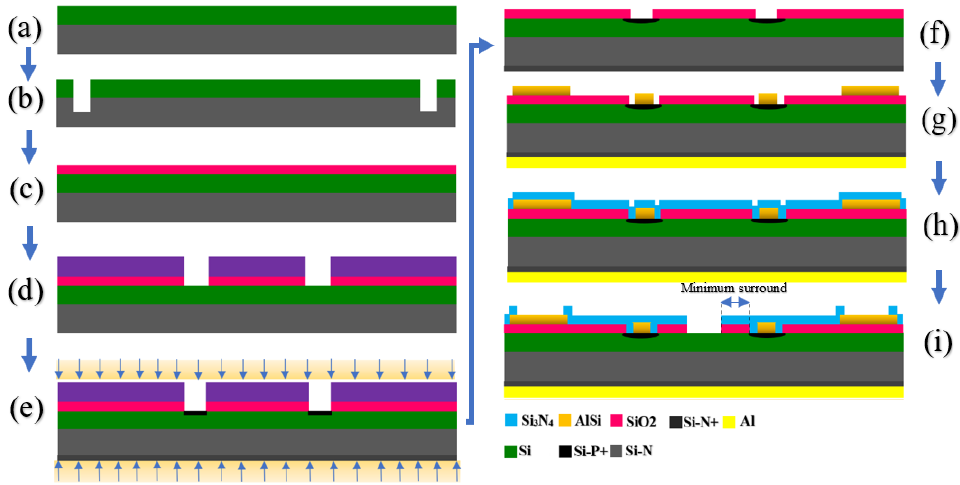
Figure 3. Schematic of OG-FET sensor showing the main material composition of the sensor. ( a ) Substrate wafer (silicon <100>, 100 mm diameter, 420 +/ − 25 µm thick, resistivity 0.006 to 0.02 Ohm.cm). ( b ) Alignment marker definition (first mask). ( c ) PECVD SiO 2 deposition. ( d ) SiO 2 etching to Si layer (second mask). ( e ) Front- and back-side ion implantation. ( f ) Implantation annealing. ( g ) Front- and back-side metallization and annealing. ( h ) PECVD Si 3 N 4 deposition (passivation layer). ( i ) Pad and channel opening.